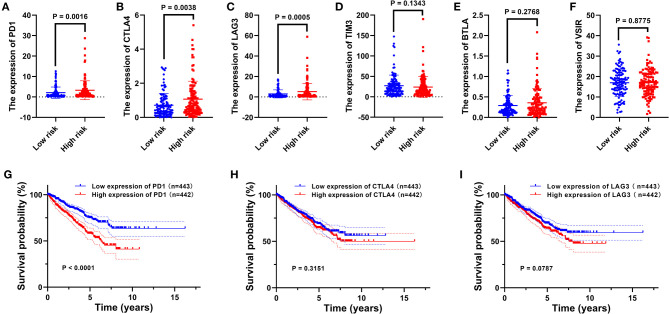
The relationship between the present signature and immune checkpoints. Expression analysis of PD1 (A), CTLA4 (B), LAG3 (C), TIM3 (D), BTLA (E), and VSIR (F) between two risk groups. The Kaplan–Meier curve of PD1 (G), CTLA4 (H), and LAG3 (I). The median expression level was used as the cut-off value. p < 0.05 was considered statistically significant.